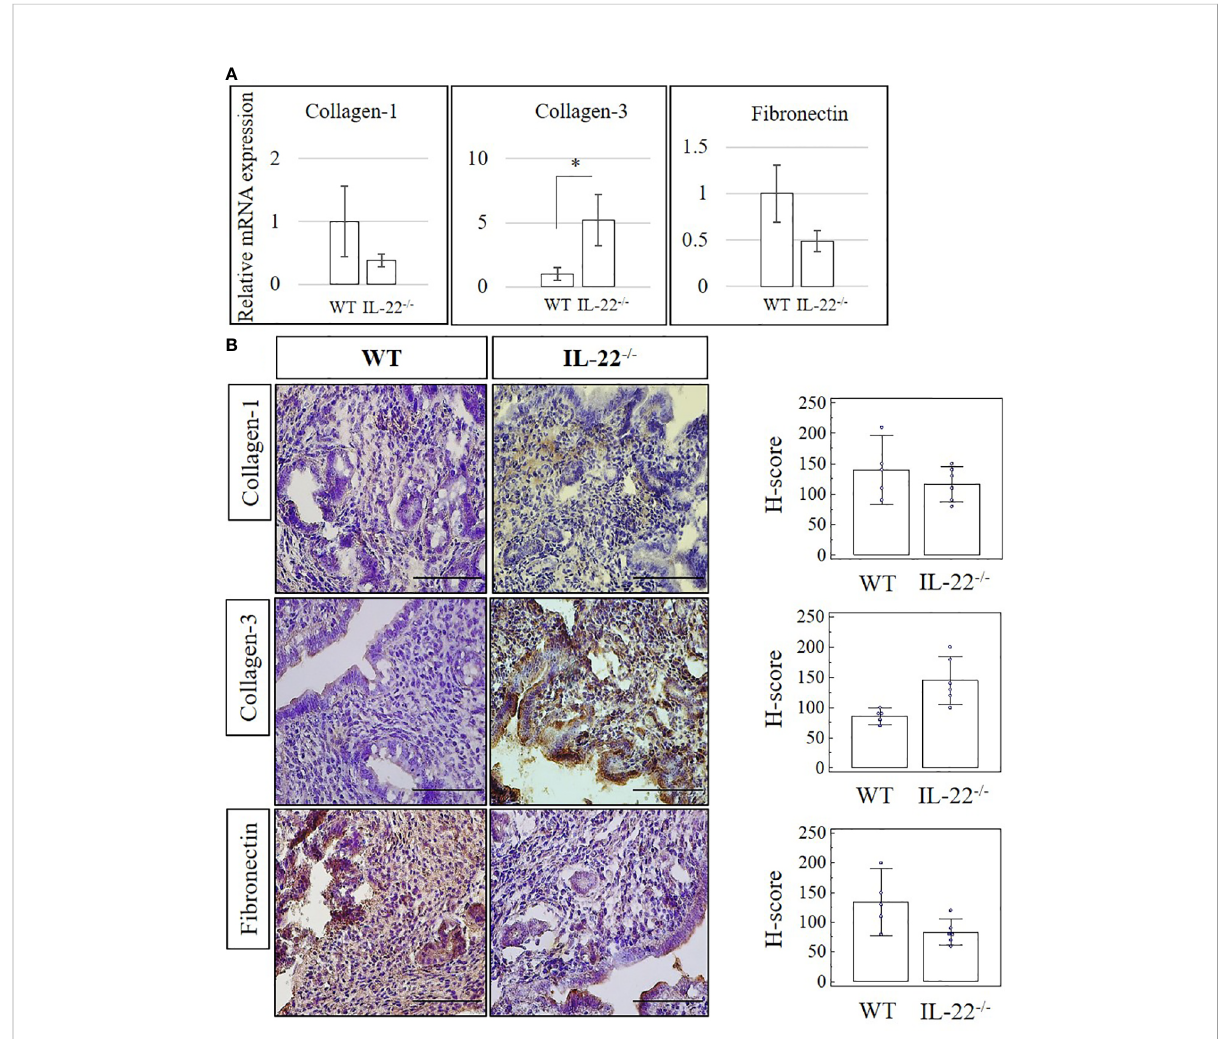
FIGURE 2 The expression of extracellular matrix proteins in IL-22 − / − and WT mice. (A) IL-22 − / − , n = 6, and WT, n = 5, mouse uterine samples were harvested 48 h post intraperitoneal LPS injection. Total mRNA samples were extracted and processed by qRT-PCR to evaluate the expression of Collagen-1, Collagen-3, and fi bronectin. The data are provided as mean ± SEM from three independent experiments. (B) IL-22 − / − , n = 6, and WT, n = 5, mouse uterine samples were harvested 48 h post intraperitoneal LPS injection, frozen fi xed, and processed for IHC analysis. Original magni fi cation, ×40; scale bar, 100 µm. H-score of ECM proteins was calculated to measure whether the difference in the staining between the groups is statistically signi fi cant. The data from the t-test are provided as mean ± SEM. WT, wild type; IL-22 − / − , IL-22 knockout; H-score, histological score; LPS, lipopolysaccharide; IHC, immunohistochemistry; ECM, extracellular matrix. * p <